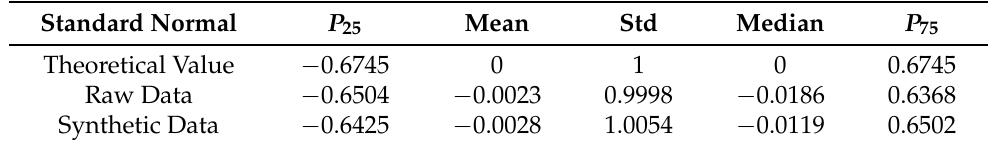
Table 1. Population parameters of a standard normal distribution and their point estimates considering the raw data and synthetic data generated from those raw data.